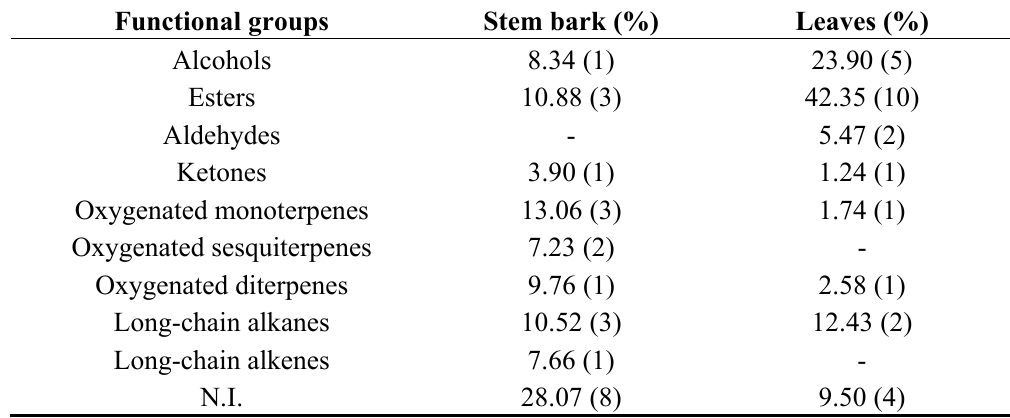
Table 2. Chemical class distribution of the essential oil components from the stem bark and leaves of I. laurina in the dry